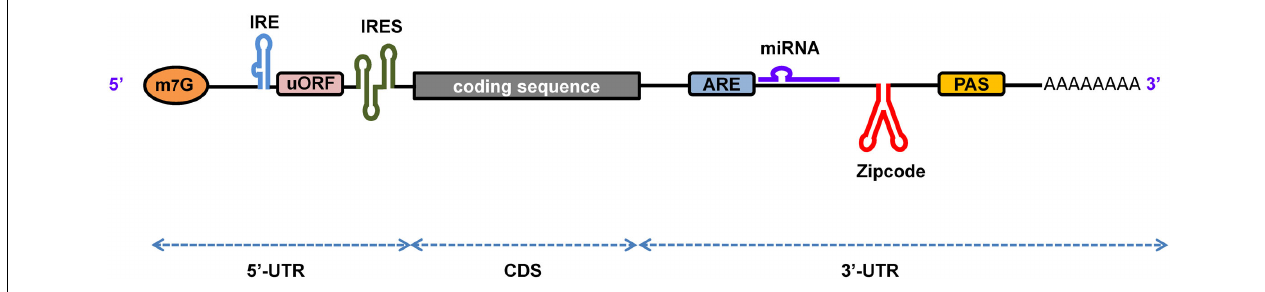
FIGURE 1 |A schematic representation of eukaryotic mRNA with functional elements. UTR, untranslated region; CDS, coding sequence; m7G, 7-methyl-guanosine cap; IRE, iron-responsive element; uORF, upstream open reading frame; IRES, internal ribosome entry site; ARE, AU-rich element; PAS, poly(A)